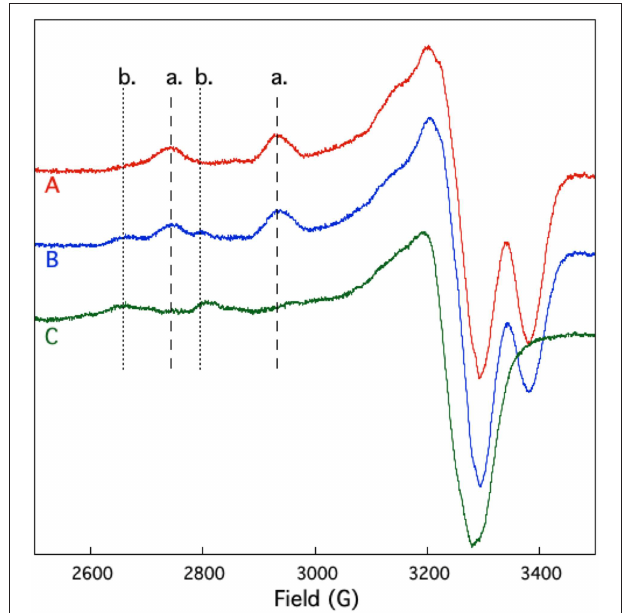
FIGURE 7 | Competition for UO 2 + 2 and Cu 2 + binding to SUP investigated by EPR spectroscopy. Spectrum A: pre-formed SUP-Cu 2 + complex (1:1 stoichiometry). Spectrum B: pre-formed SUP-Cu 2 + 2 (1:2 stoichiometry), showing both hyperfine coupling bands for site a and site b. Spectrum C: pre-formed SUP-Cu 2 + complex (1:1 stoichiometry) after addition of 1 equivalent of UO 2 + 2 , showing that Cu 2 + is displaced from site a by UO 2 + 2 and re-bound at site